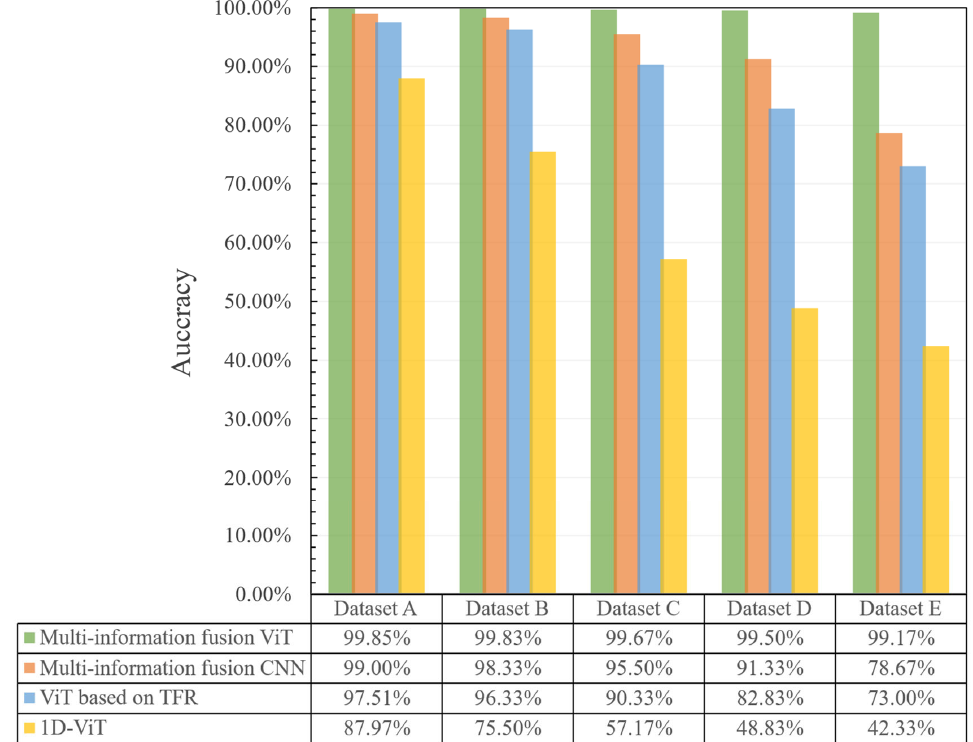
Figure 11. Diagnosis accuracy for Datasets A, B, C, D, and